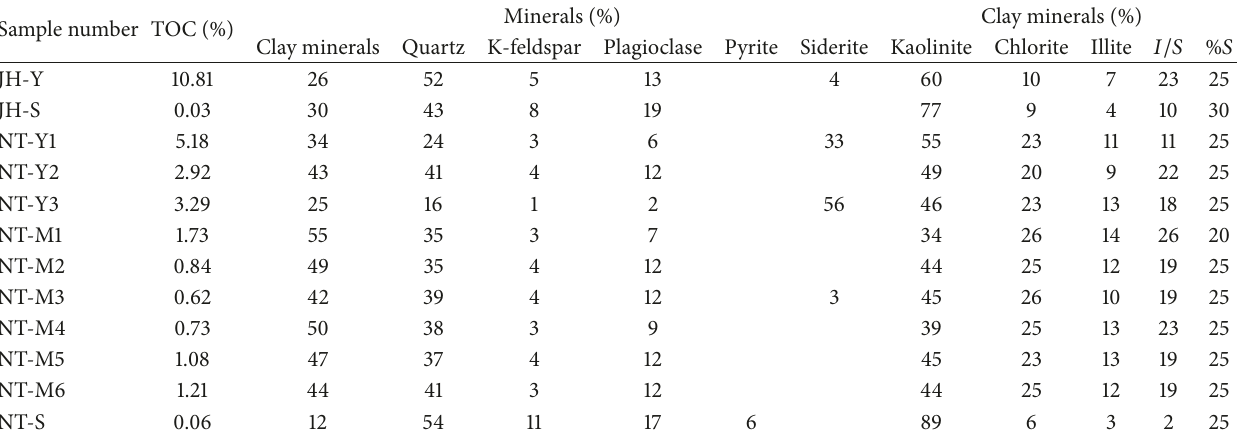
Table 2: Total organic carbon (TOC) contents and mineralogical compositions of the investigated rock samples. Minerals (%) Clay minerals (%) Sample number TOC (%)